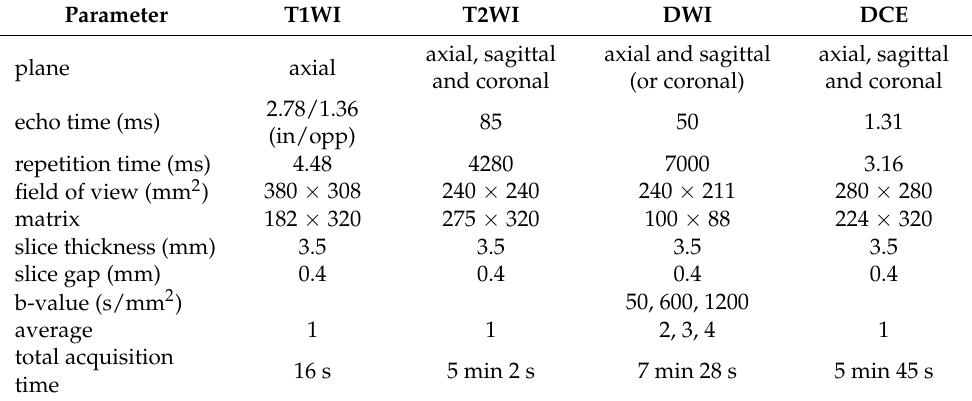
Table 1. 3.0-T MRI protocol